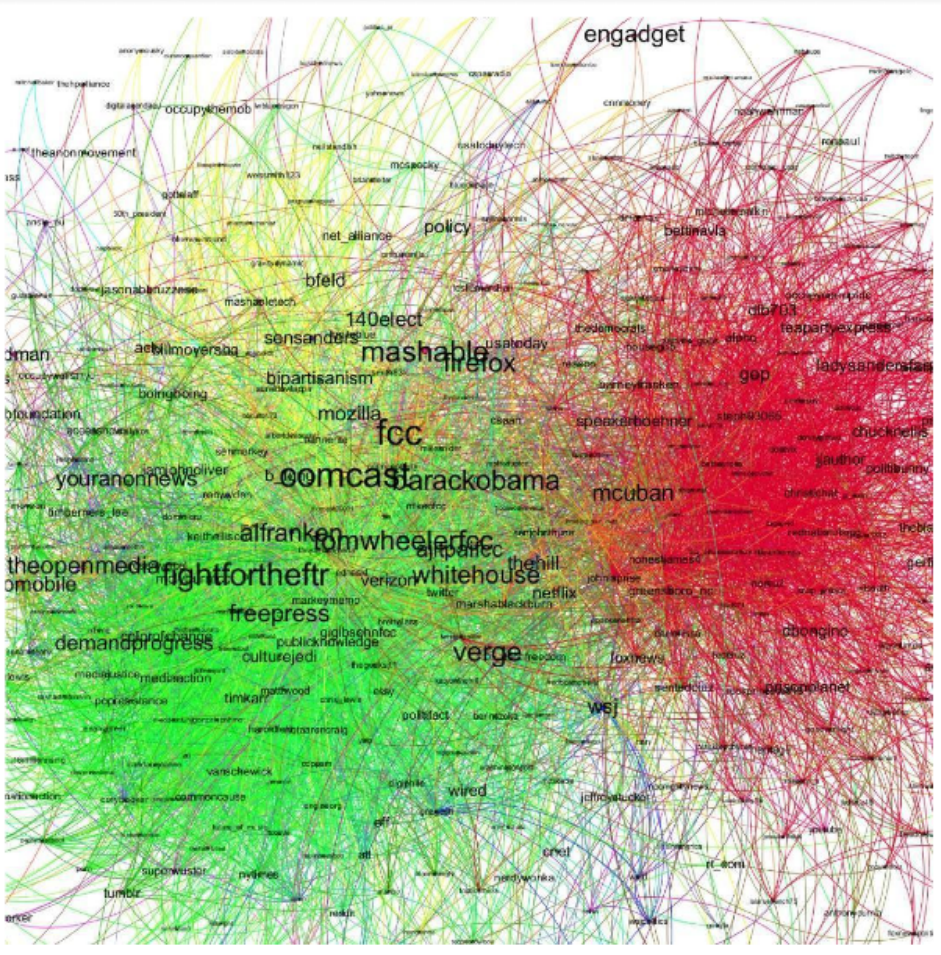
Figure 2: Twitter network on